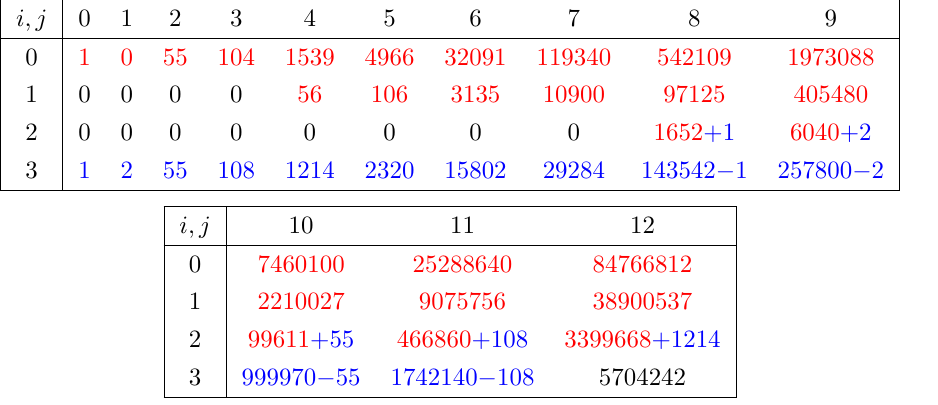
for the elliptic genus of two F 4 instanton strings. i;j